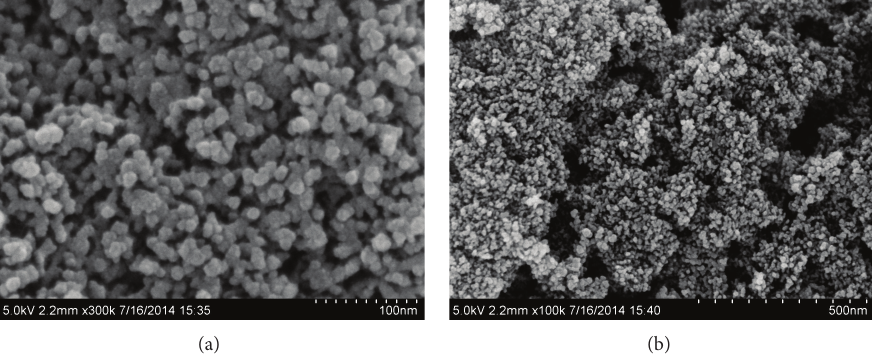
Figure 5: Representative scanning electron microscopy images of the modified nanodiamonds.